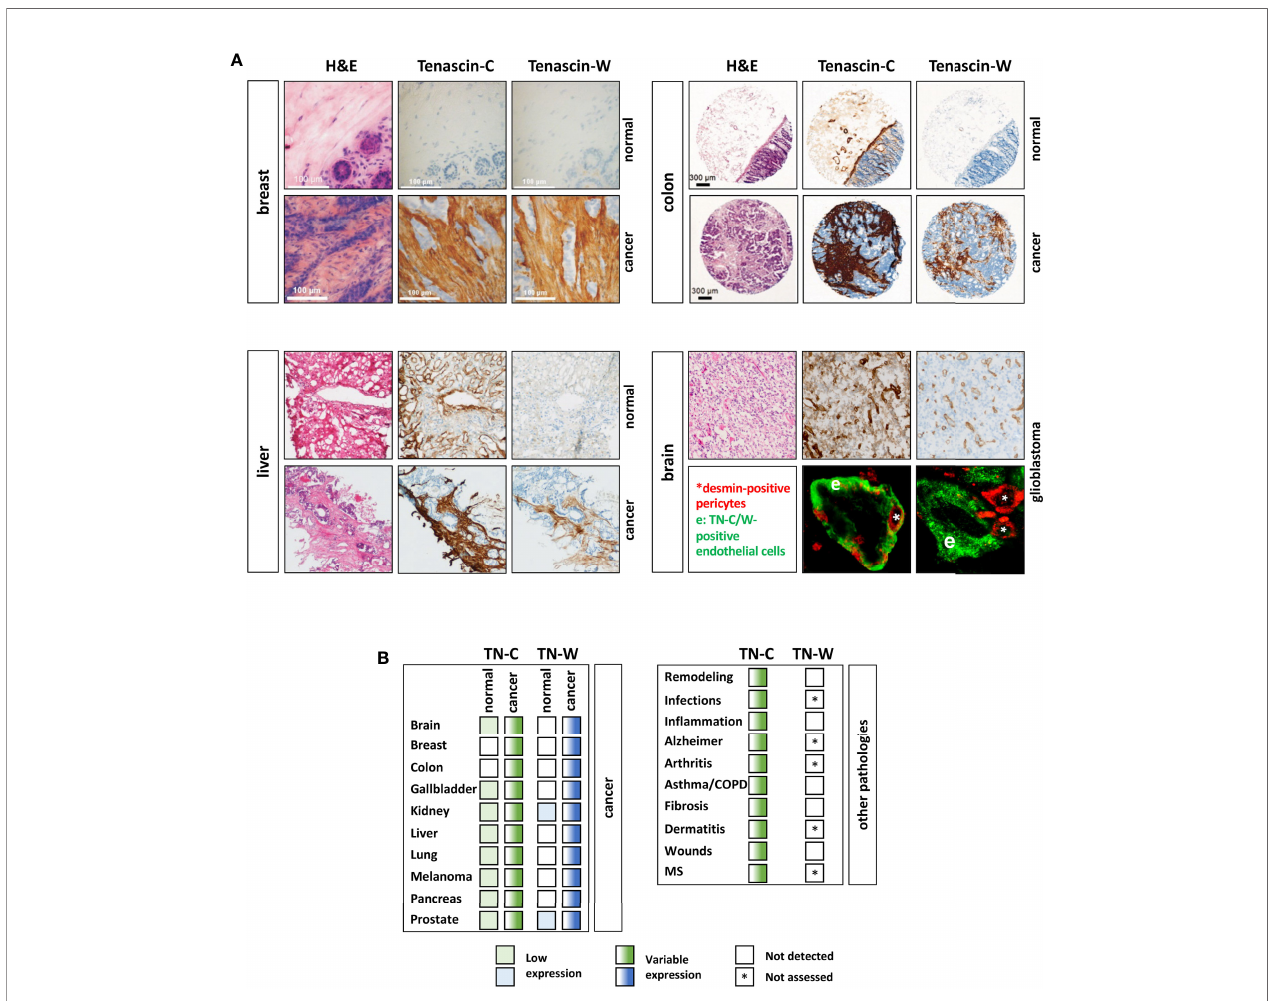
FIGURE 4 | TN-C and TN-W expression in human cancers. (A) Examples of immunohistochemical analyses of TN-C and TN-W in human breast, liver, and colorectal cancer as well as in adjacent normal tissues. Note that while TN-W is not expressed in healthy tissues, TN-C is detectable in colon and liver. In glioblastoma TN-C and TN-W show strong expression around vessel-like structures (top). Double immuno fl uorescence staining of TN-W or TN-C (green) with desmin (red) shows that TN-C encloses all pericytes, while TN-W staining is adjacent to them. Original images of breast tissue from Degen et al. (88), of liver tissue from Hendaoui et al. (89), of colon tissue from Degen et al. (52), and of brain tissue from Martina et al. (90) with permission. (B) Table of all cancer/normal tissues that have been analyzed so far for TN-W and TN-C by immunohistochemistry and/or immunoblotting (left). Right table shows non-cancerous conditions with TN-C upregulation and non-detectable (white box) TN-W expression. Fully colored boxes: expressed; gradient-colored boxes: variable expression ranging from low (light) to high (dark). * not assessed yet; MS, multiple